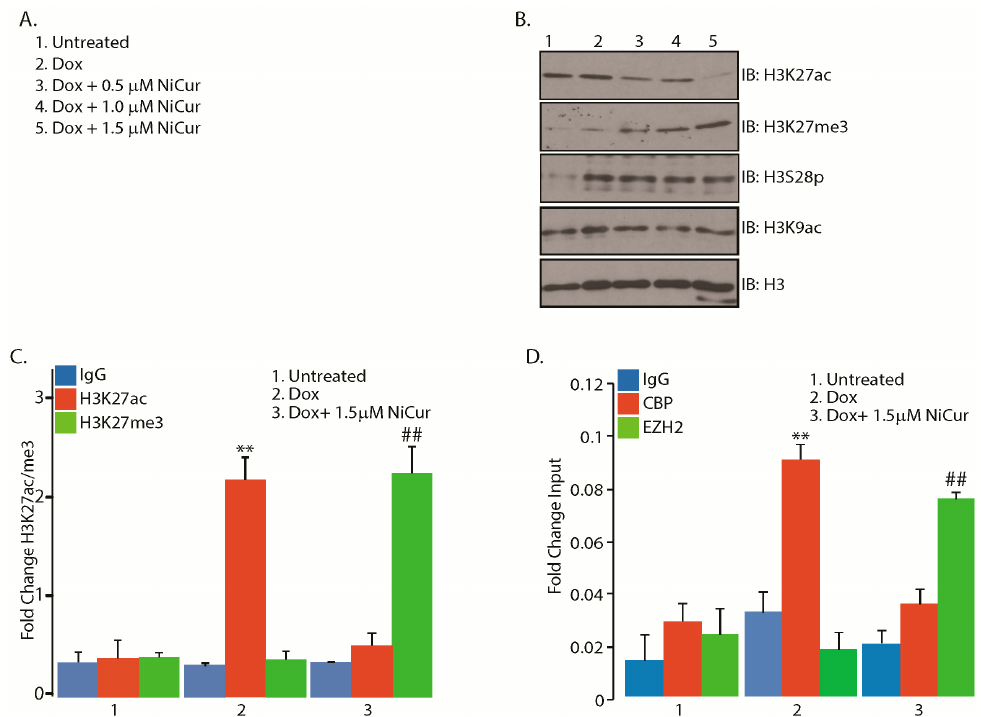
Figure 4. NiCur reprograms chromatin landscape from acetylation, H3K27ac, to tri methylation on lysine 27 of histone H3, H3K27me3. ( A ) Experimental conditions followed for the treatment of U2OS cells with Dox alone and together-with NiCur; ( B ) The nuclear extracts from U2OS cells treated with Dox alone and together-with NiCur were subjected to IB, which revealed that without affecting the levels of H3K9ac and H3S28p, downregulation of H3K27ac in the presence of NiCur led to an increase in the level of H3K27me3 on the chromatin; ( C ) ChIP-qPCR assay on the promoter of CDKN1A/p21 promoter demonstrates that treatment of U2OS cells by Dox results in ~2-fold increase acetylation on H3K27 site, which is reversed by NiCur that leads to a ~2-fold increase in methylation; ( D ) Increased occupancy of CBP by ~3-fold on CDKN1A/p21 promoter was reversed by the occupation of EZH2 after treatment of U2OS cells with NiCur. The fold changes upon the treatment of U2OS cells with Dox alone and together-with NiCur that lead to enrichment of H3K27ac/CBP versus H3K27me3/EZH2 were expressed as the mean ± SEM ( n = 3 ), with significance at p < 0.05 or p < 0.01 as indicated by ** and ##,